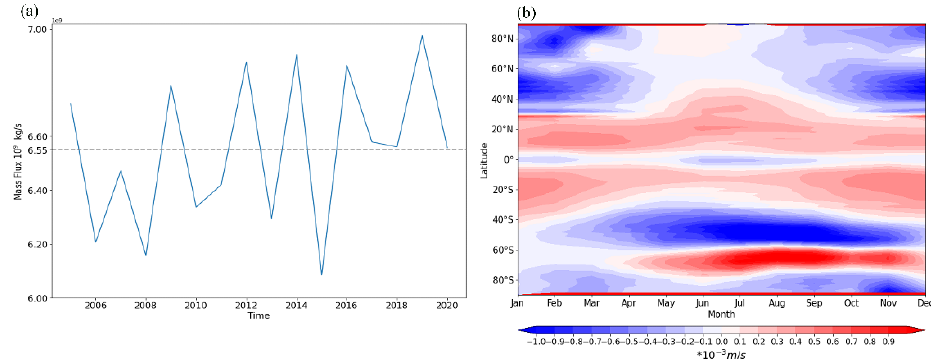
Figure A2. The correlation coefficient (R value) of the monthly average tropical upwelling mass flux at 70 hPa to the local monthly average N 2 O concentration at ( a ) 1 hPa, ( b ) 10 hPa, ( c ) 21.54 hPa, ( d ) 31.62 hPa, ( e ) 46.42 hPa, and ( f ) 68.13 hPa. Only correlation coefficients with a confidence of more than 90% are shown on the graph.